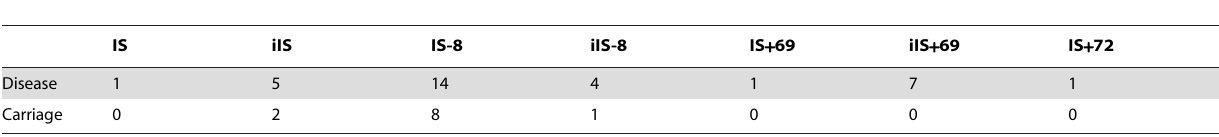
Table 3. Characteristics of IGRs with IS 1301 in 44 MenB isolates from South East England.